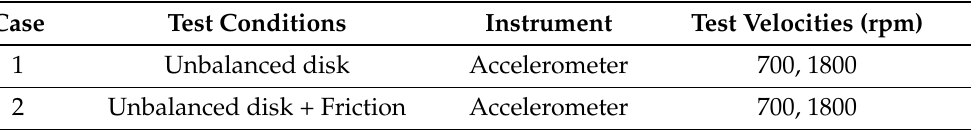
Table 2. Test conditions for the